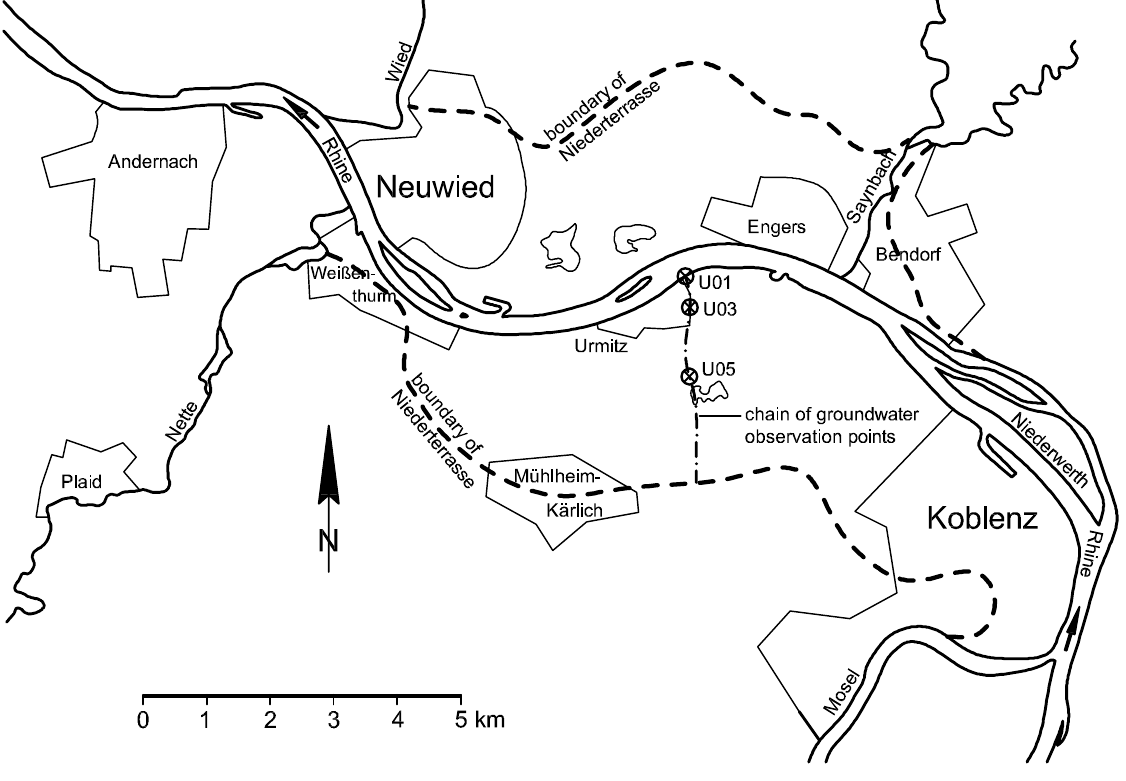
Figure 4. Overview of the Neuwieder Becken and the chain of groundwater observation points near Urmitz (after [12]). The observation wells U01, U03 and U05 are referred to in Figure